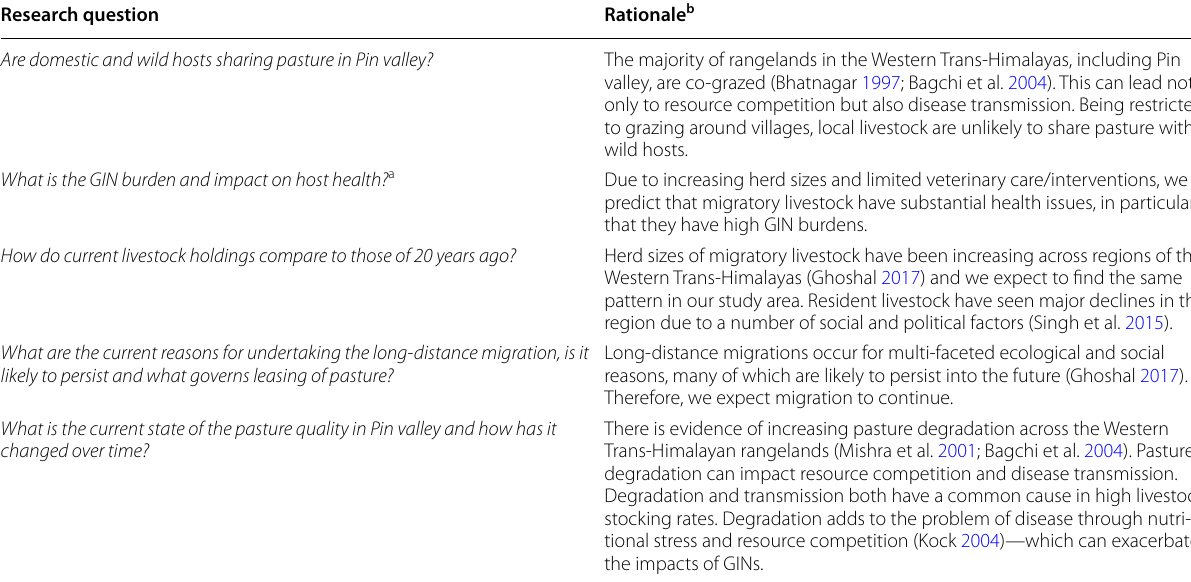
a This is supplemented by the endo-parasite analysis; see the “Endo-parasites in ibex and livestock” section. b While we are unable to rigorously or systematically test the hypotheses expressed here, we articulate them in order to clarify the rationale behind our research